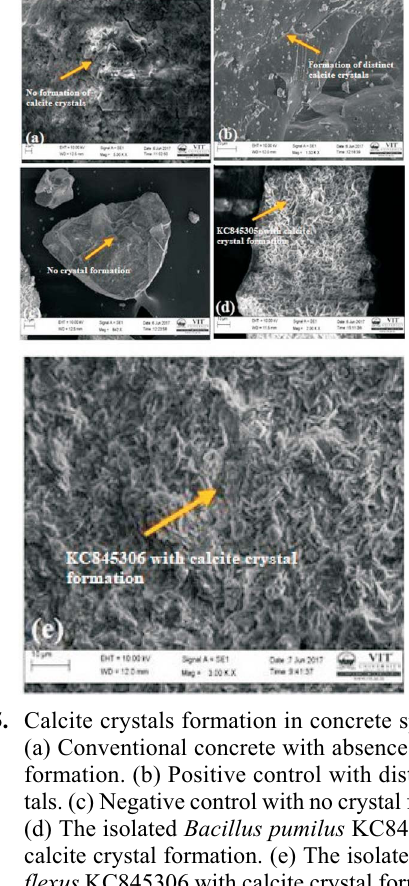
Figure 5. Calcite crystals formation in concrete specimens. (a) Conventional concrete with absence of crystal formation. (b) Positive control with distinct crys- tals. (c) Negative control with no crystal formation. (d) The isolated Bacillus pumilus KC845305 with calcite crystal formation. (e) The isolated Bacillus flexus KC845306 with calcite crystal